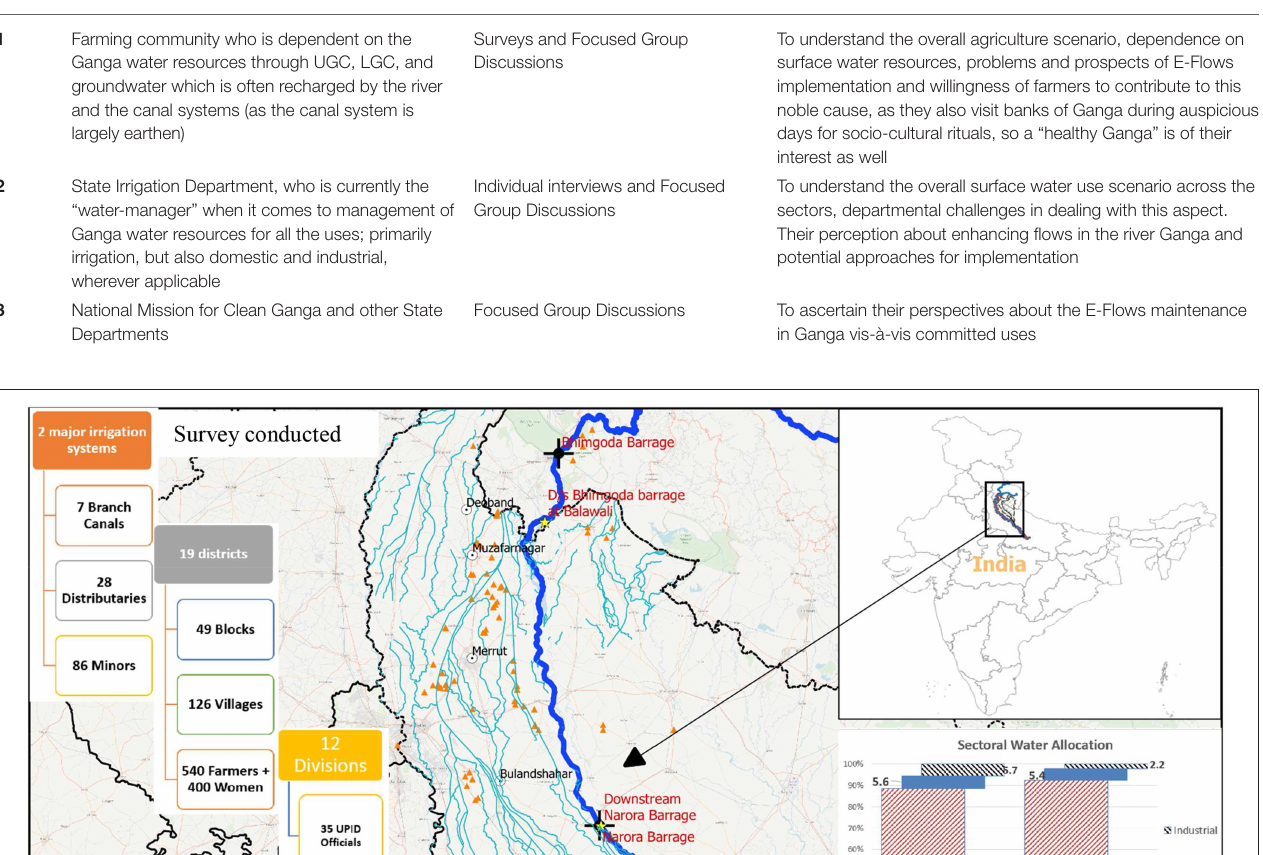
TABLE 2 | Key stakeholders and objective of interactions with them. S.